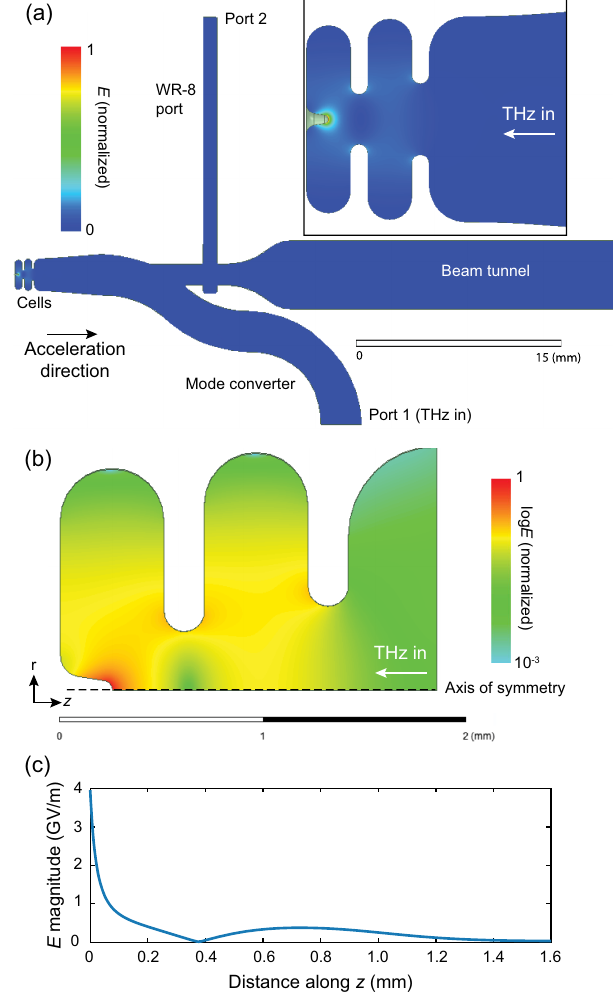
FIG. 2. (a) Electric field in the vacuum space of the mode converter and gun structure on the π mode resonance. The simulation assumes mirror symmetry across the plane shown and uses copper surface resistivity for all external boundaries of the vacuum space excluding ports and the beam tunnel exit. The electric field is shown in normalized units. Power is input from port 1 and coupled into the cells. The inset shows the field profile in the cells including field enhancement at the tip. (b) Log-scale plot of the electric field in the cells, showing the field balance between the two cells. This simulation assumes cylindrical symmetry around the dashed line. (c) On-axis electric field magnitude for an input power of